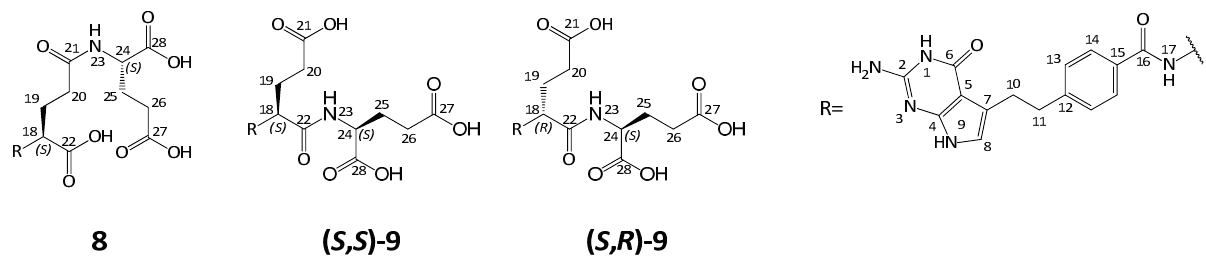
Figure 3. Numbering of atoms in the NMR spectra description for compounds 8 , ( S , S ) -9 and ( S , R ) -9 (Table